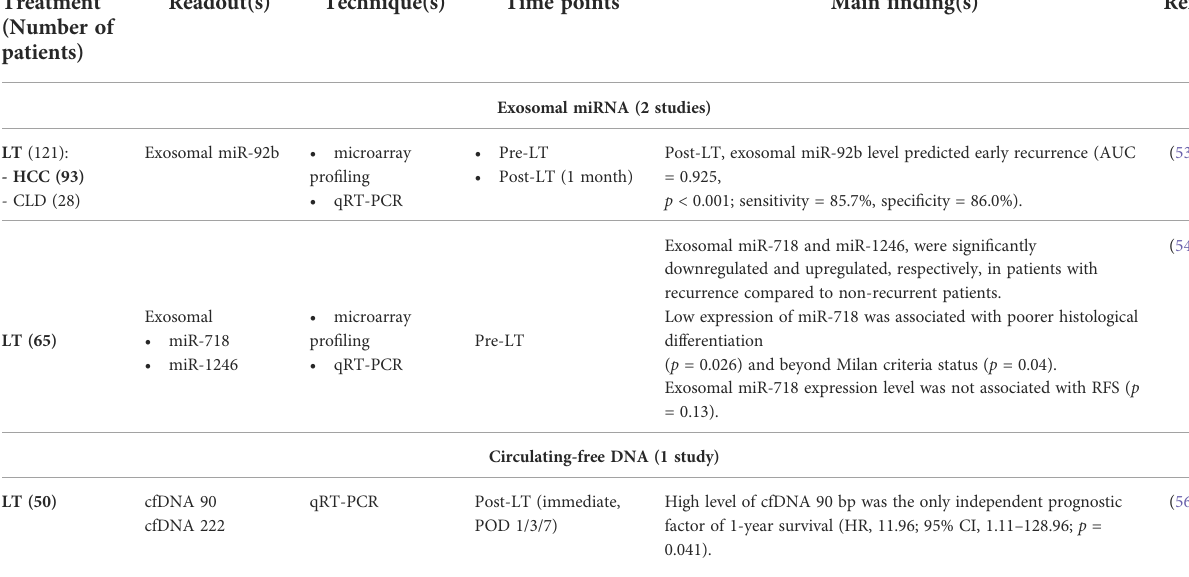
TABLE 3 Exosomal RNAs and circulating-free DNA in liver transplantation for hepatocellular carcinoma. Treatment (Number of